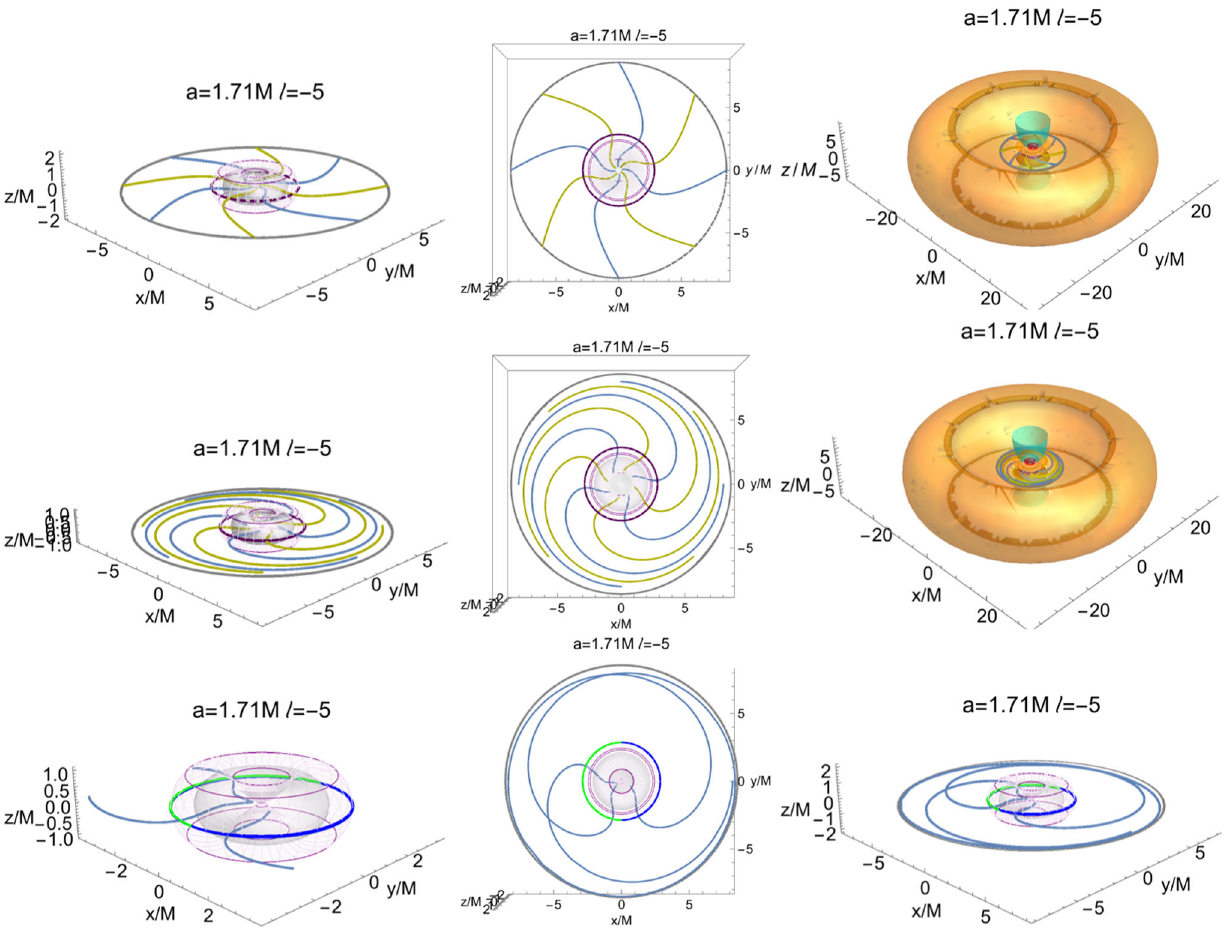
Fig. 23 Photons orbits (upper line) and test particle orbits (center line) with trajectories inversion points the NS geometry with spin a = 1 . 71 M . The specific angular momentum is (cid:6) = − 5. The ini- tial radius is r 0 < r × , where r × is the torus inner edge. The inversion sphere r (cid:2) islight-purplesurface.Ontheequatorialplaneradius r ± (cid:2) isthe